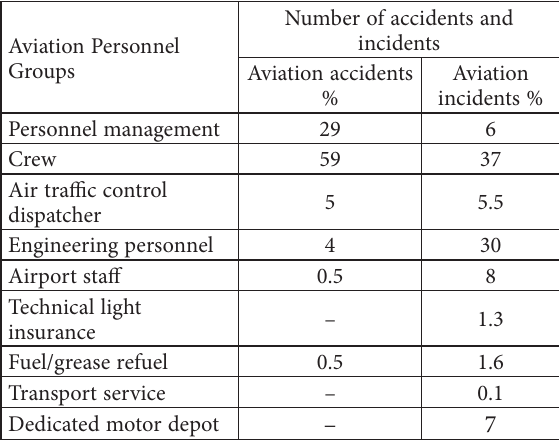
Table 1. Classification of aviation accidents and incidents according to the leading aviation personnel